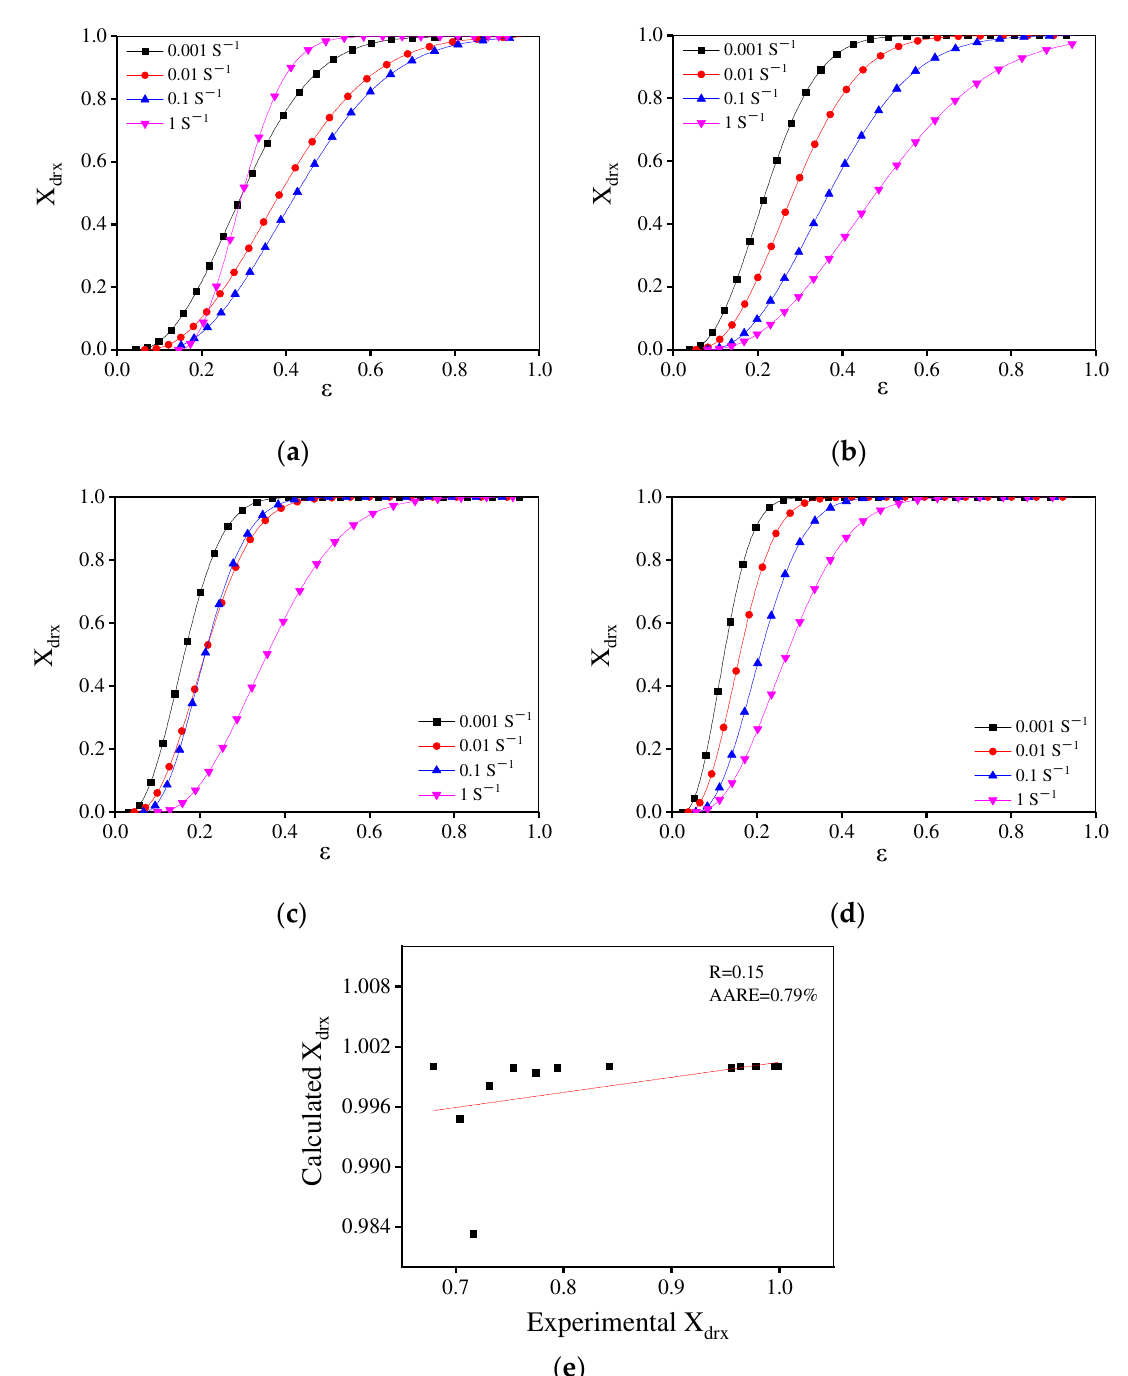
Figure 13. The effects of strain rate and strain on X drx at ( a ) 1080 °C; ( b ) 1110 °C; ( c ) 1140 °C; ( d ) 1170 °C. ( e ) The comparisons between the calculated and experimental X drx .